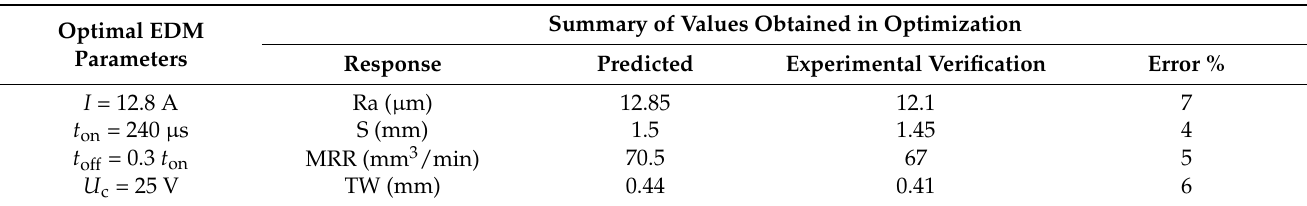
Table 11. Experimental validation of the values obtained from multi-response optimization.